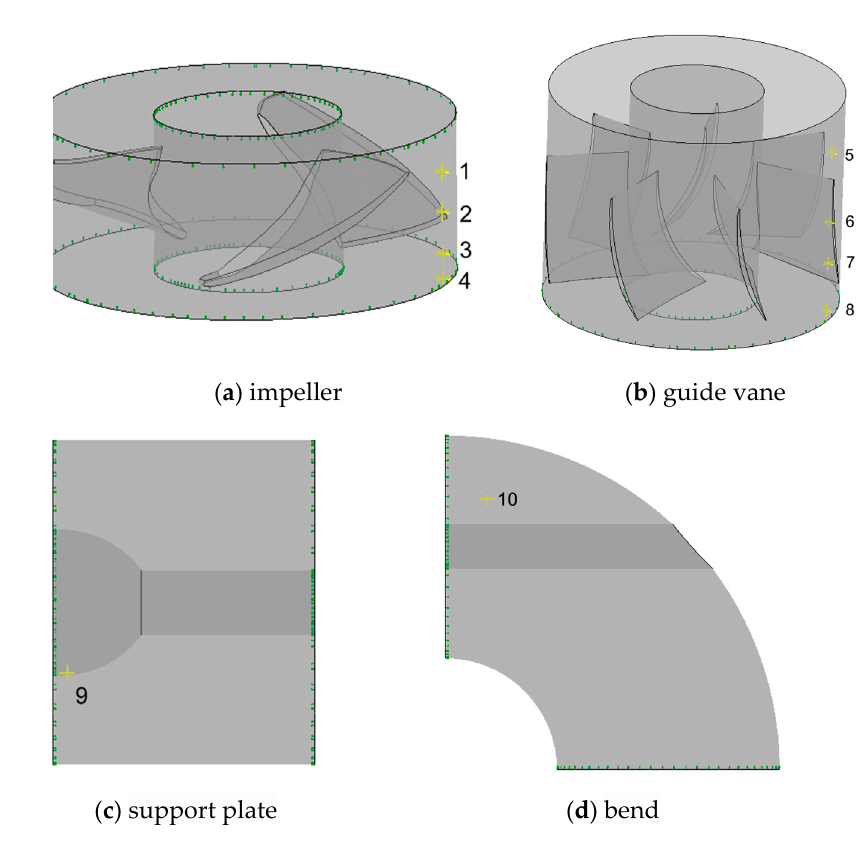
Figure 11. Layout of monitoring points.